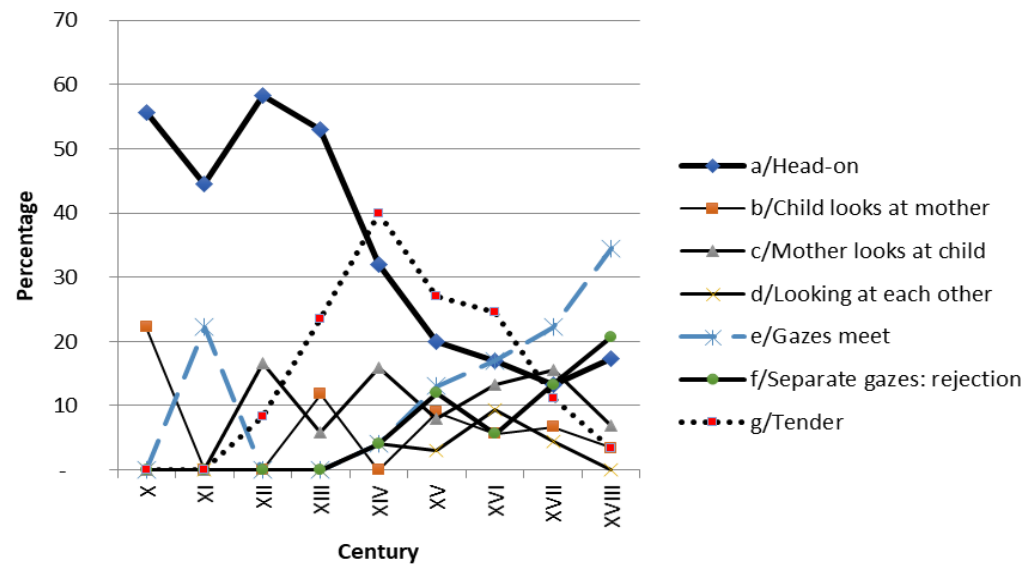
Figure 8. Mother–child gaze in representations of Mary (Spain, tenth to eighteenth centuries). Source: Authors’ elaboration based on Trens (1946).